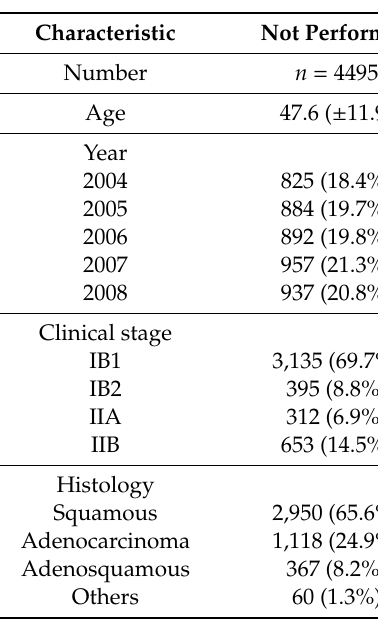
Figure 2. A regression-tree model for the utilization of peritoneal cytology testing at surgery. Abbreviations: SCC, squamous cell carcinoma; Adeno, adenocarcinoma; AS, adenosquamous; and NACT, neoadjuvant chemotherapy. Table 1. Patient demographics based on peritoneal cytology performance ( N = 5942).